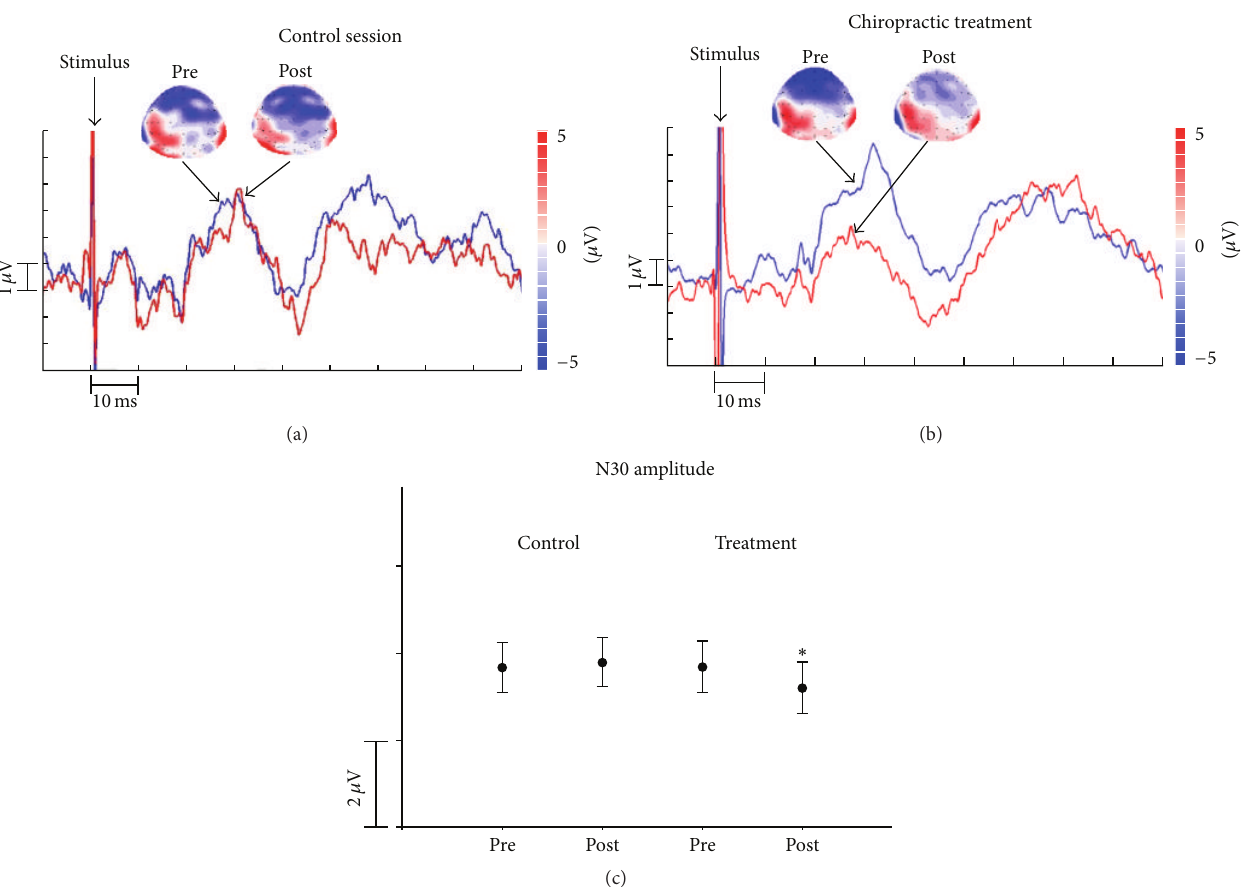
Figure 1: (a) Waveforms and topographies of baseline against the recording after control treatment. Blue waveform is baseline. Topographies are N30 topographies. This is a plot of one representative subject. (b) Waveforms and topographies of baseline against the recording after chiropractic treatment. Blue waveform is baseline. Topographies are N30 topographies. This is a plot of one representative subject. (c) Error bars for N30 amplitude. ∗ represents significant